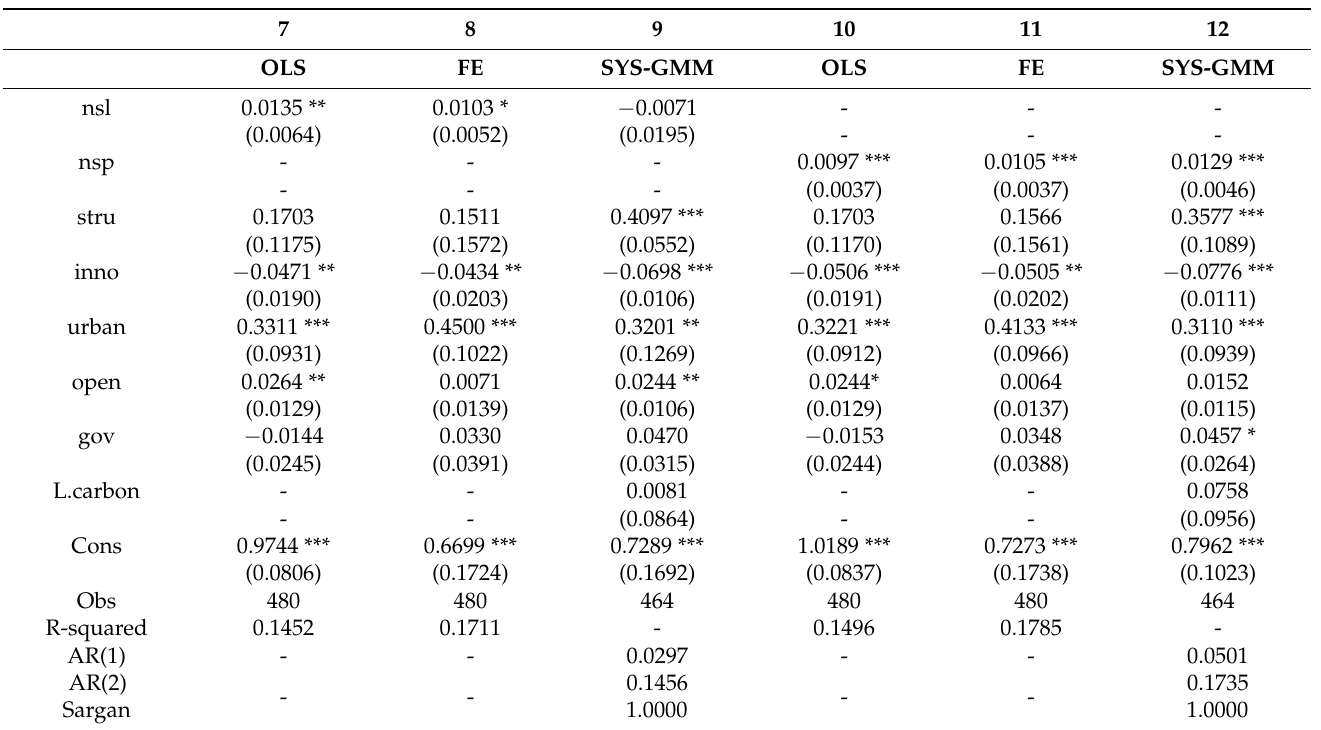
Table 3. Impacts of national standard dominance and national standard participation on carbon- emission efficiency.